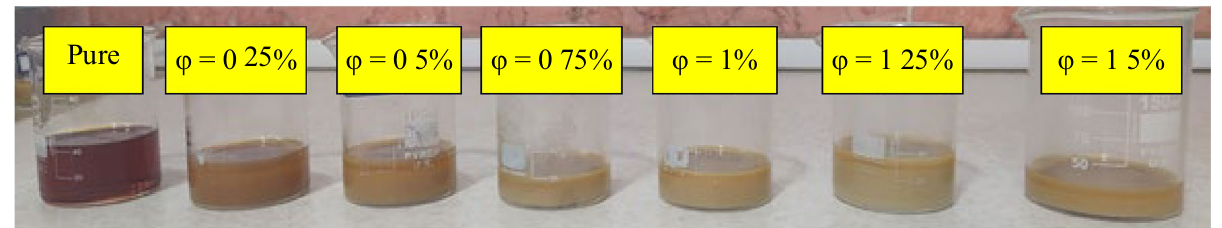
Figure 4. Ternary-hybrid nanofluids samples in different VFs.